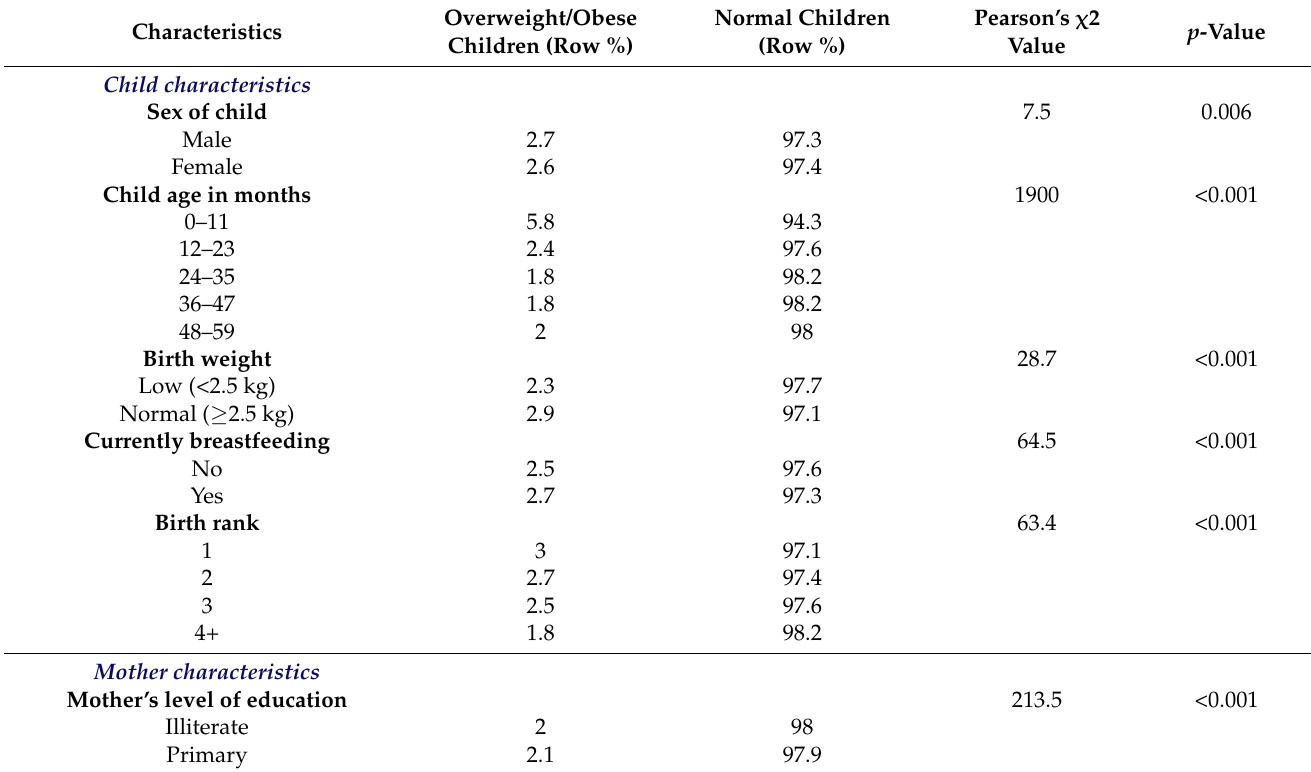
Table 3. Prevalence of overweight/obesity by sociodemographic and household characteristics of under-five children in India ( n =